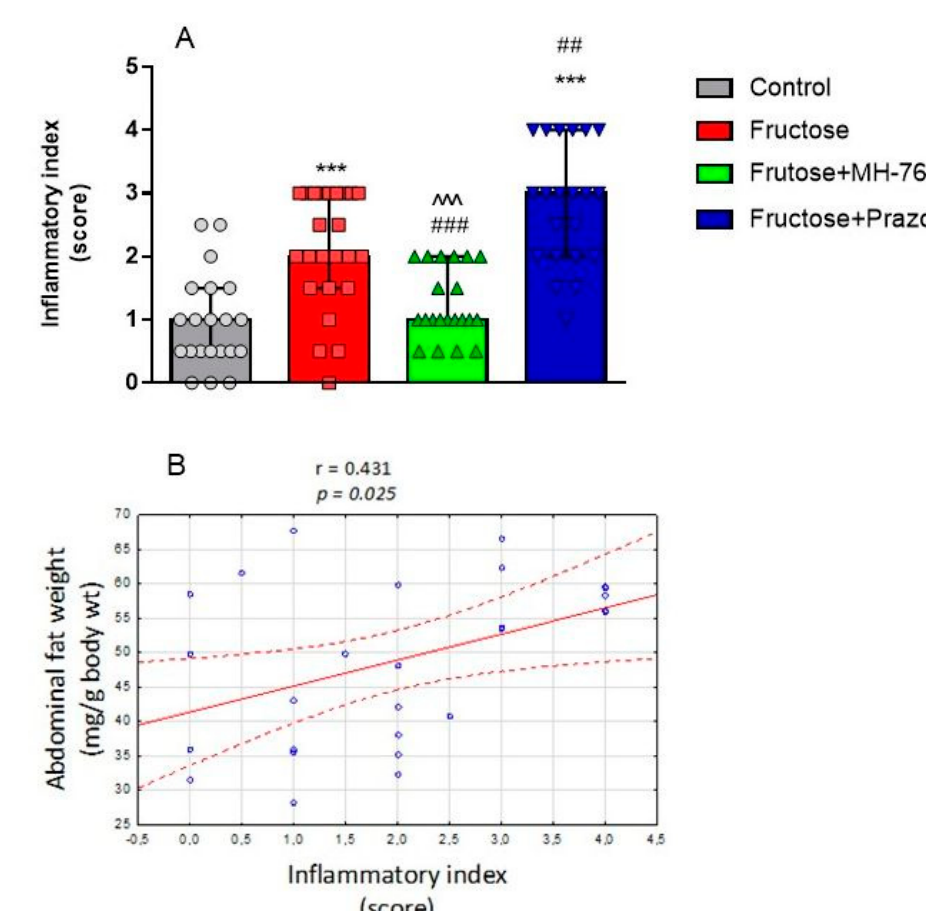
Figure 6. ( A ) Inflammatory index of abdominal adipose tissue in the different groups of rats. Data are expressed as median + IQR, *** p < 0.001 vs. Control, ## p < 0.01, ### p < 0.001 vs. Fructose, ˆˆˆ p < 0.001 versus Fructose + Prazosin, (Kruskal–Wallis test by ranks, post hoc Dunn test). ( B ) Significant positive correlation between abdominal fat weight (mg/g body wt) and inflammatory index (Pearson